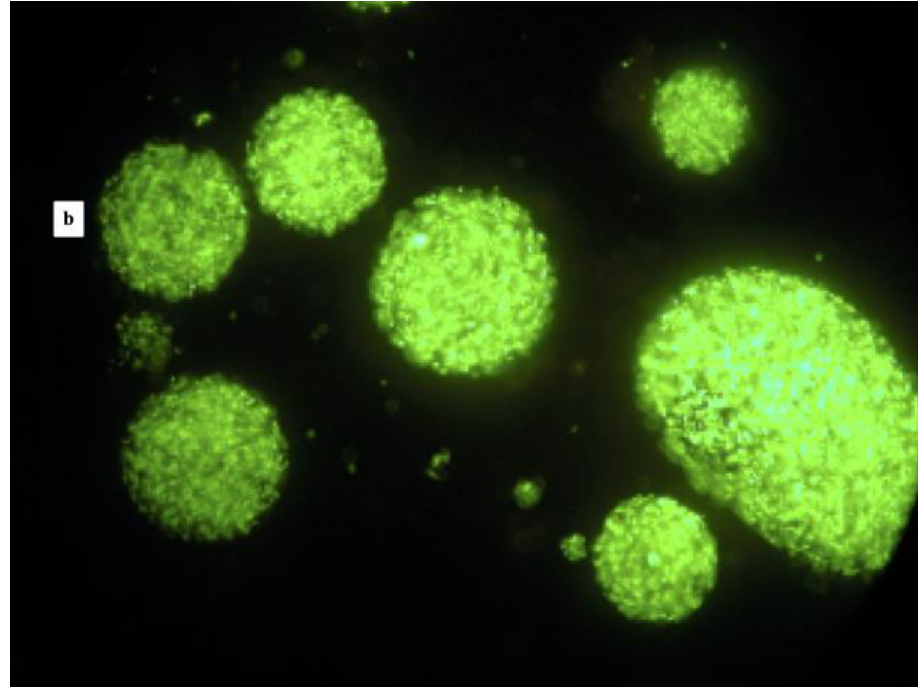
Figure 1. Fluorescence microscopy images at 400× magnification of microencapsulated cells of L. reuteri DSM 17938 (panel a ) and L. plantarum 48M (panel b ) after viable staining. Results regarding the shape and size of microcapsules are in agreement with other studies where microcapsules obtained by emulsion technique were analysed. In particu- lar, Truelstrup Hansen et al. [24] reported that microcapsules loaded with bifidobacteria observed by cryo-scanning electron microscopy were spherically shaped with a smooth or rough surface with a visible outline of entrapped bacteria. Similarly, Khalida Sultana et al. [27] obtained spherical and some elliptical beads with randomly distributed bacteria in the alginate matrix. Finally, Valero-Cases and Frutos [28] obtained by emulsion smaller and more irregularly shaped microcapsules containing L. plantarum CECT 2020, compared to that obtained by the extrusion method. Each phase obtained after the microencapsulation process was analysed for viable counting, and results are reported in Table 1. No viable cells were detected in the oily phase, while average values of 7.36 and 4.47 Log CFU/mL were registered in water middle phase for L. reuteri DSM 17938 and L. plantarum 48M, respectively. Similar differences between the strains were also detected in the counting of microencapsulated cells. In fact, average values of 9.04 and 7.63 Log CFU/mL were registered in the bottom phase for L. reuteri DSM 17938 and L. plantarum 48M, respectively. Consequently, the encapsulation efficiency for L. reuteri DSM 17938 was found to be significantly ( p < 0.05) higher than L. plantarum 48M. The microencapsulation efficiency was calculated after adjusting the volumes of the phases by applying the formula previously described (Section 2.4). Specifically, the CFU/mL value was adjusted to 100 mL for both the culture and the aqueous phase: 100 mL represents the initial volume of the overnight culture to obtain the microbial pellet used for the microencapsulation procedure. Therefore, the microencapsulation yield was 65.28% for the L. plantarum 48M and 91.53% for L. reuteri DSM 17938 (Table 1). In the light of the microencapsulation efficiency results, we can hypothesise that different CFU/mL values of obtained phases depend on different compositions of the two strains’ bacterial cell membrane, causing diverse interactions with the microencapsulation agents. As a matter of fact, some authors investigated the interaction between bacterial cells and hydrogels, and they found that even the bacterial growth medium can affect this interaction